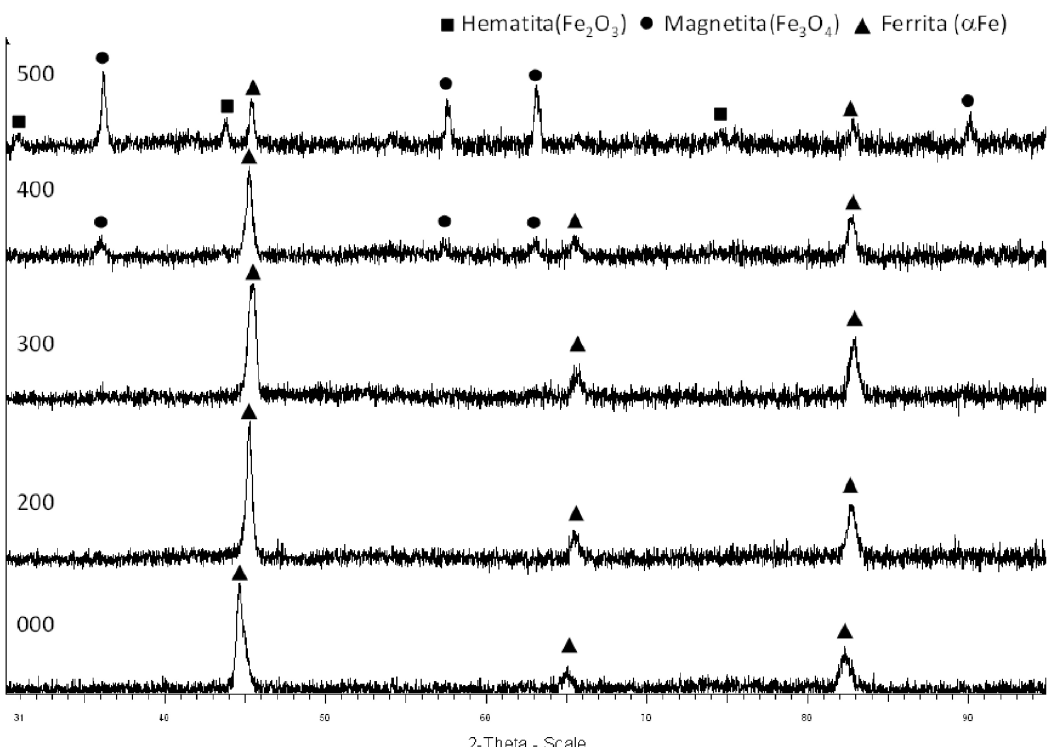
Figure 5. Crystalline phases of the wool samples after thermal treatment under an inert atmosphere. From bottom to top: Initial sample, sample treated at 200 °C, sample treated at 300 °C, sample treated at 400 °C, and sample treated at 500 °C.